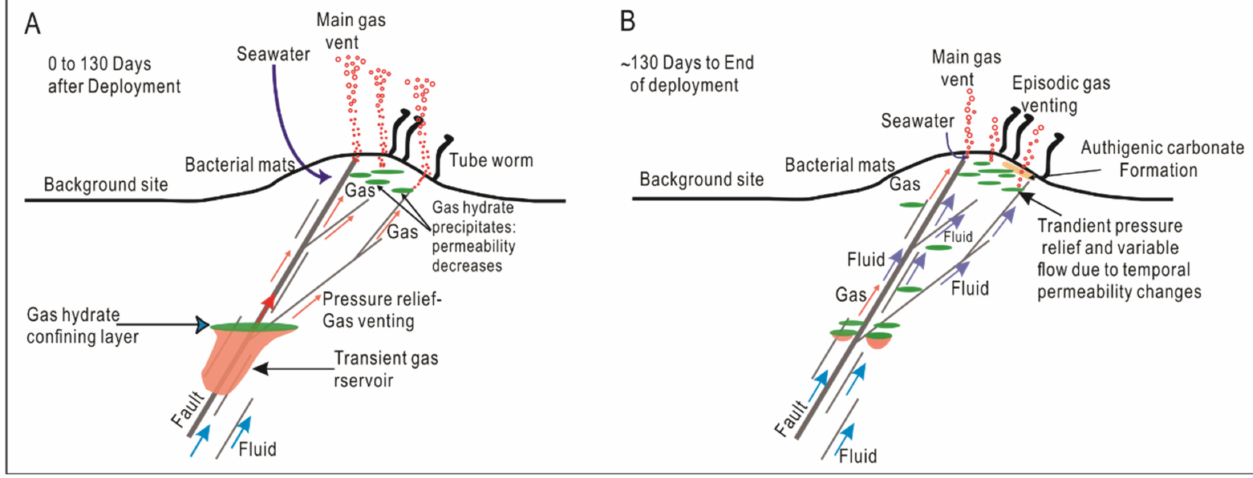
Figure 15. Proposed conceptual model of the formation of hydrate outcrops on the seafloor at Bush Hill (Site GC185) according to a 15-month deployment test. ( A ) First 130 days. A hydrate-confining layer traps large amounts of gas migrating along the antithetic fault (described in Figure 14), creating an overpressured gas reservoir capable of driving fractures that channel the gas toward the seafloor. ( B ) From 130 days to the end. The focused gas release disrupted the hydrate-confining layer. Variable gas venting is caused by changes in sediment permeability determined by shallow hydrate and authigenic carbonate precipitation over time (cited from